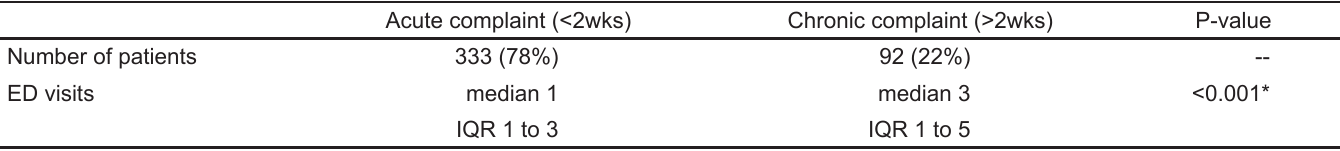
Table 2. Number of emergency department (ED) visits by patients presenting with acute vs. chronic chief complaints.